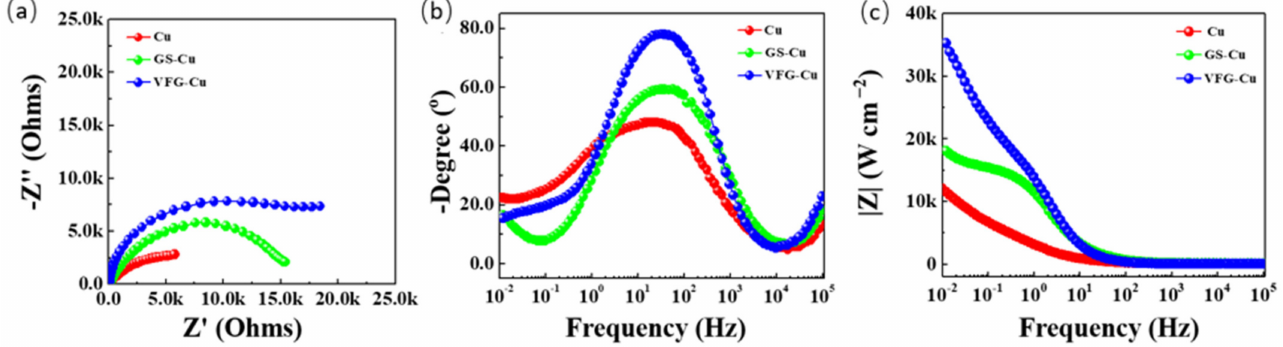
Figure 5. ( a ) Nyquist plots for Cu, GS-Cu, and VFG-Cu ( b ), ( c ) Bode magnitude plots for Cu, GS-Cu, and